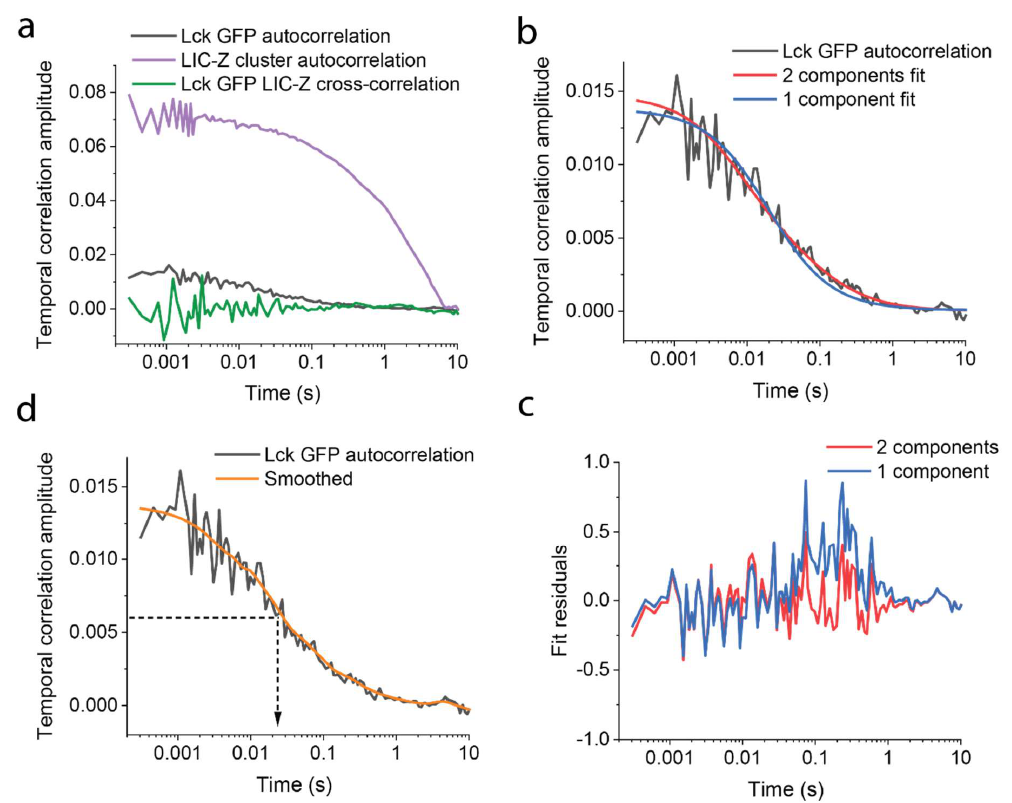
Figure A3. ( a ), Representative autocorrelations and cross-correlation of Lck GFP and LIC-Z clusters as indicated. ( b ), representative model fit of the Lck GFP temporal autocorrelation curve (black) to one component (blue) or two component (red) two-dimensional free diffusion models as described in methods. ( c ), the residuals of the corresponding fit shown in b. The residuals are normalized by the standard deviation of the 20 auto-correlation curves along the line. The sum of squared residuals for the 1 component and 2 component fit were 6.70 and 2.79, respectively. ( d ), the fitting free approach to estimate the diffusion time of Lck GFP, which is the correlation lag time at half the value of the G(0) that extrapolated from the smoothed raw autocorrelation curve.